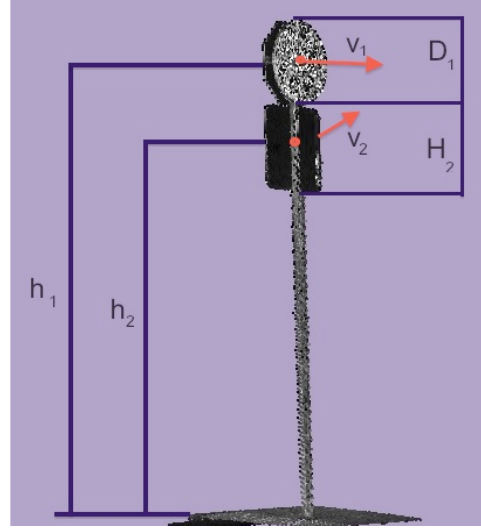
Figure 8. Some of the geometric features that can be automatically extracted from point clouds to define explicit geometry of traffic